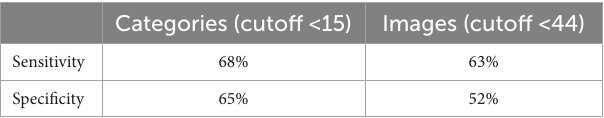
TABLE 2 Sensitivity, specificity, and accuracy with the selected cutoff